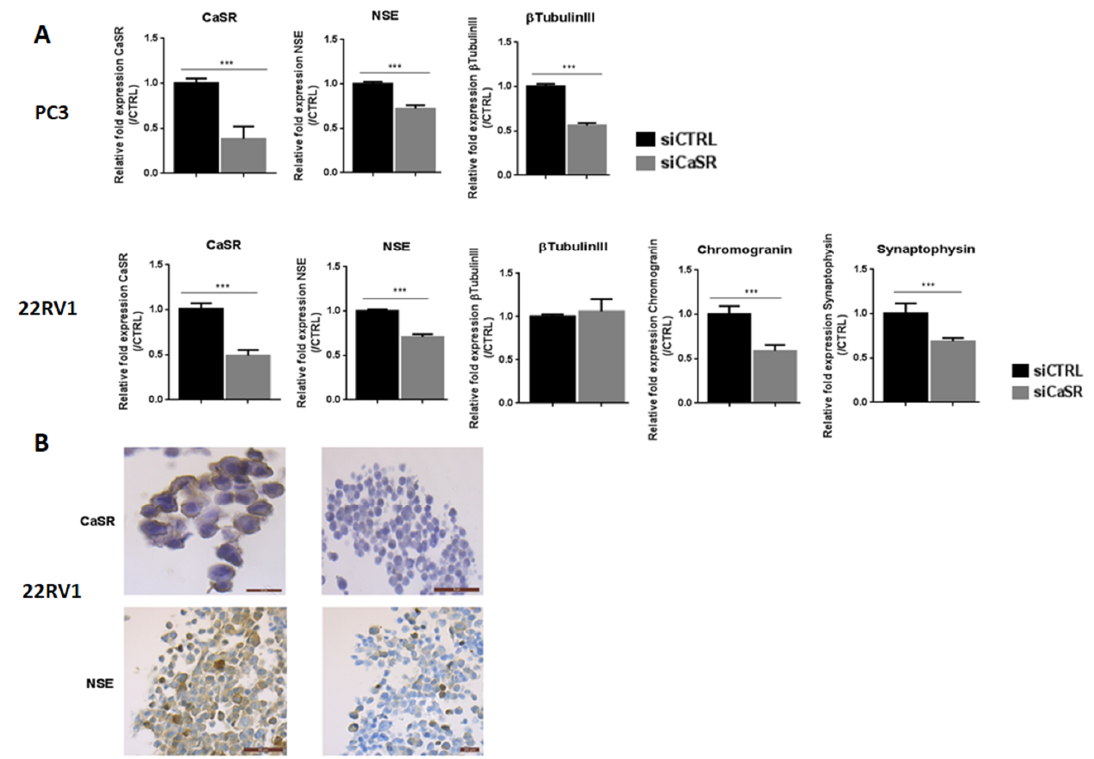
Figure 5. ( A ). Effects of CaSR inhibition on the expression of NE markers in PC3 and 22RV1. Cells were transfected with a siRNA control (siCTRL) or directed against CaSR (siCaSR) for 48 h (qPCR analysis were performed 48 h post-transfection). Results are normalized to control condition and are expressed as mean ± S.E.M. The statistical differences are indicated: *** p < 0.001 (Mann–Whitney). n = 3. ( B ). Immunohistochemical expression of CaSR and the neuronal marker NSE in 22RV1 cells, transfected with either a siRNA control (siCRTL) or directed against CaSR (siCaSR) for 48 h. CaSR inhibition is confirmed by an absence of immunostaining, and led to a decrease in NSE expression, from focal to almost diffuse.